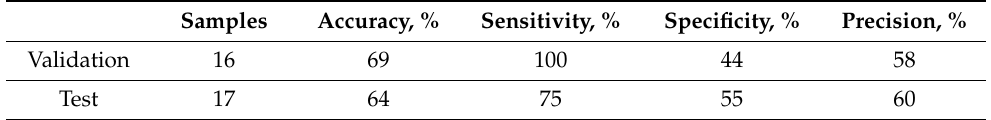
Table 2. Computing model results for discriminating HFpEF versus